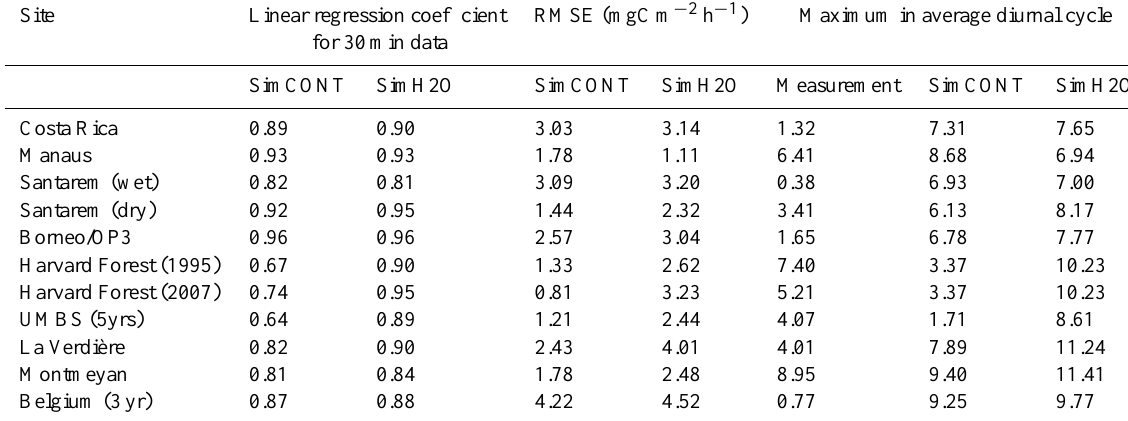
Table 7. Statistical performance of model simulated isoprene average diurnal cycles at 9 sites in the tropical and temperate zones. Site